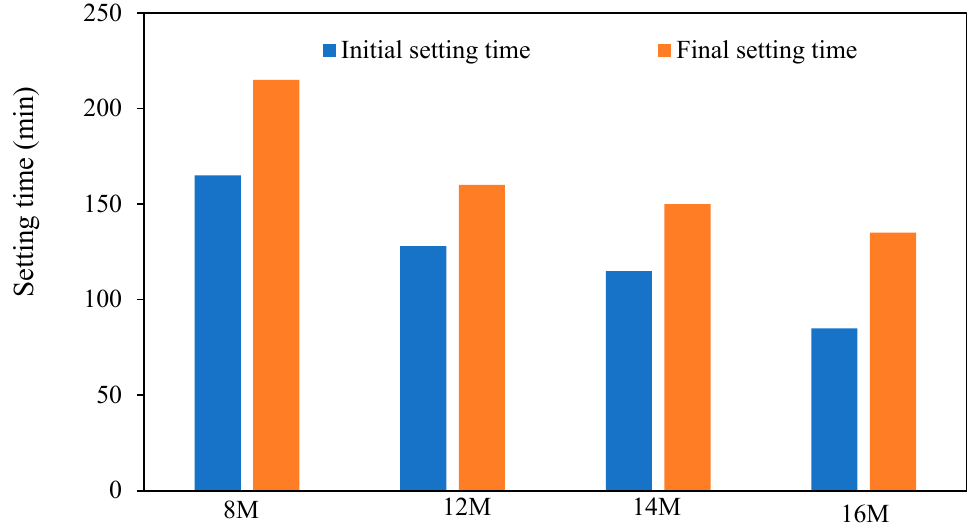
Figure 10. Effect of NaOH molarity on GPM setting times [43].